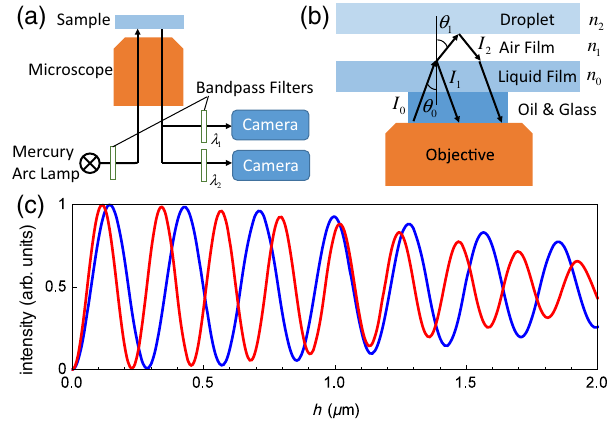
FIG. 4. (a) Experimental setup for measuring the evolution of air film. (b) Schematic illustration of the RICM setup. (c) A sample plot of Eq. (A1) with λ ¼ 434 nm (red curve) and 546 nm (blue curve); n 0 ¼ n 2 ¼ 1 . 404 , which is the index of silicone oil, n 1 ¼ 1 for air and NA ¼ 0 . 4 . describe below. First, we extract the intensity line profile (i.e., intensity along a fixed line) at different times, as shown in Fig. 5. Next, the center height of the air gap at different times is estimated. Figure 6(a) shows the mea- sured intensity at the center, i.e., the red line in Fig. 5, and the corresponding curve fittings by Eq. (A1). Figure 6(b) shows the corresponding height evolution at the center. Finally, the height profile h ð r Þ at one specific time is obtained. The center height obtained before is used as the initial value for curve fitting. Figure 7(a) shows the measured intensity at one instant, i.e., the green line in Fig. 5, and the corresponding curve fittings by Eq. (A1) give the corresponding height profile in Fig. 7(b). By repeating the curve fitting at different times, the profiles in